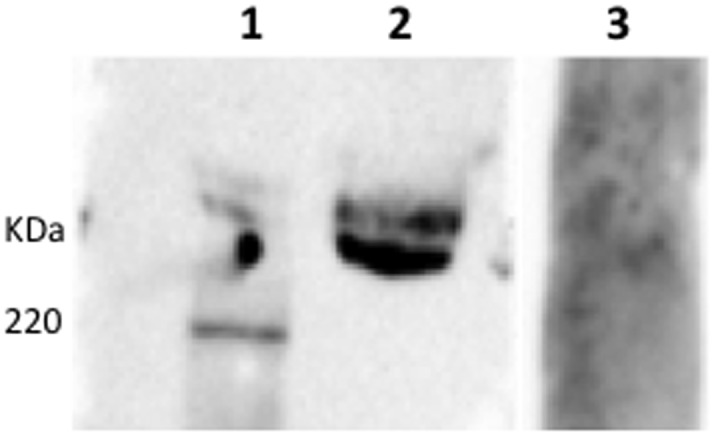
Absence of detection of intestinal MUC13 (lane 3) by anti-mucin 13 antibodies in the purified high molecular weight (MW) fraction of F4ab/acR+ BBMVs.Purification occurred by anion exchange chromatography followed by gel filtration chromatography. Strong binding of F4ac fimbriae to the high MW glycoproteins can be seen in lane 2. Lane 1: protein standard.